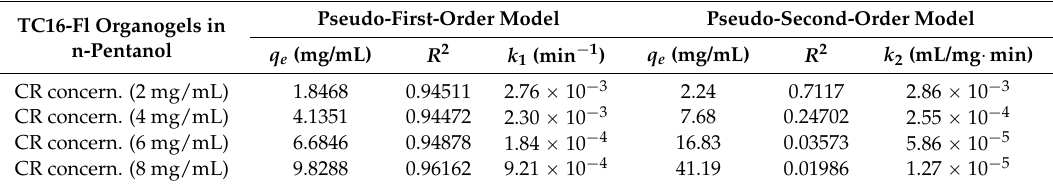
Table 2. Kinetic parameters of the as-prepared TC16-Fl organogels in n-pentanol with different CR concentrations at 298 K (experimental data from Figure